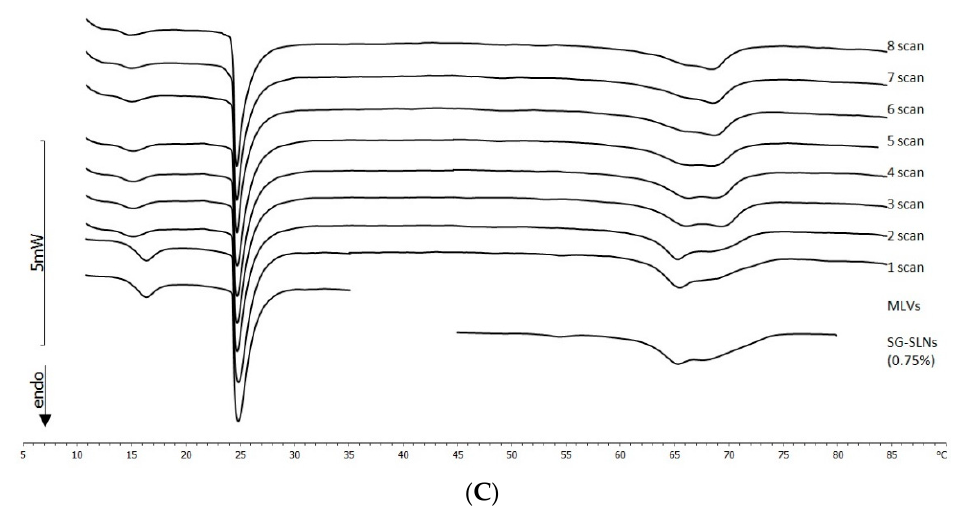
Figure 5. ( A ) Calorimetric curves, in the heating mode, of MLVs put in contact with unloaded SLNs. For comparison, calorimetric curves of the samples put in contact (MLVs and SLNs) are shown. ( B ) Calorimetric curves, in the heating mode, of MLVs put in contact with GA-SLNs (0.75%). For comparison, calorimetric curves of the samples put in contact (MLVs and GA-SLNs (0.75%)) are shown. ( C ) Calorimetric curves, in the heating mode, of MLVs put in contact with SG-SLNs (0.75%). For comparison, calorimetric curves of the samples put in contact (MLVs and SG-SLNs (0.75%)) are shown.